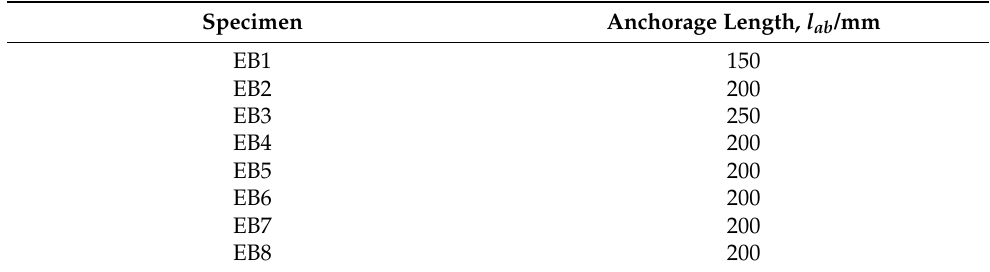
Table 8. Recommended basic anchorage lengths of the BFRP grid in the ECC matrix.